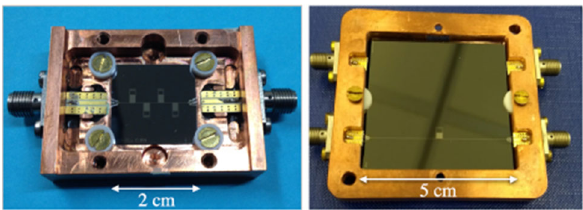
Fig. 2 Left: first prototype of light detector with 4 KIDs coupled to the same feedline and deposited on a 4 cm 2 , 300 µ m thick, silicon substrate (Picture adapted from Ref. [41]). Right: final prototype with 1 KID deposited on a 25 cm 2 , 650 µ m thick,